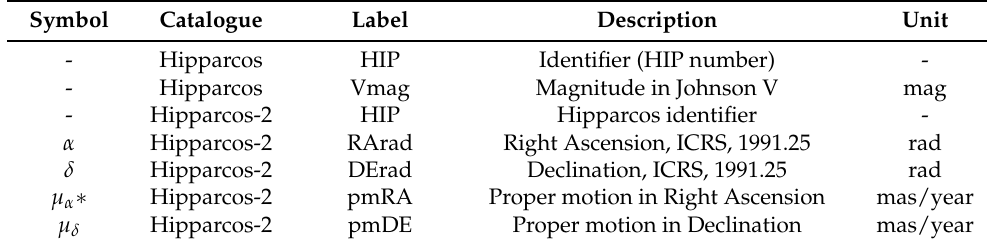
Table 2. Entries from Hipparcos and Hipparcos-2 which are of interest, adapted from